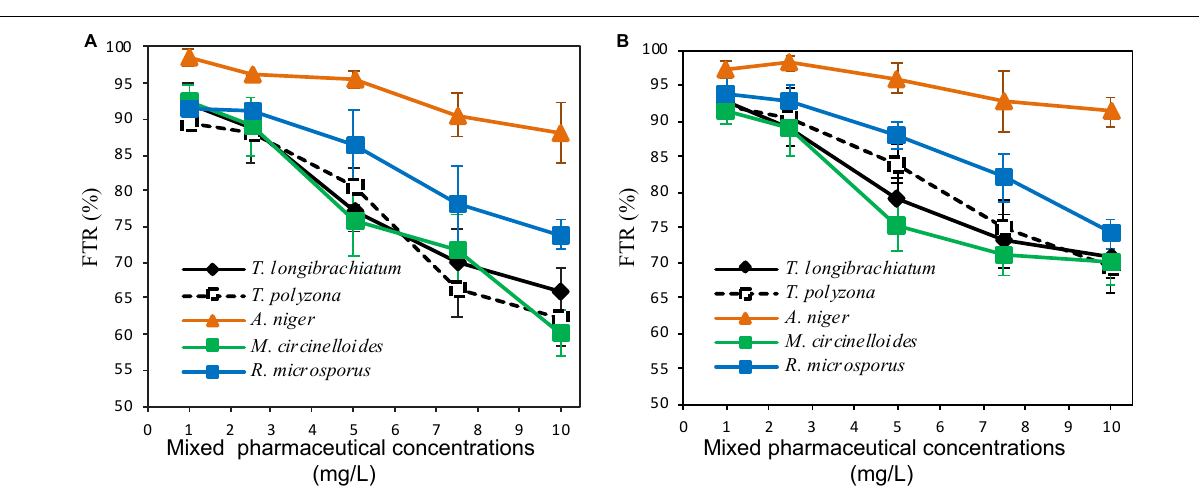
FIGURE 3 | Fungal tolerance in liquid media of mixed PhC concentrations of CBZ, DCF, and IBP ( A,B are aerated batch flasks with 10 and 30% of fungal inoculum,